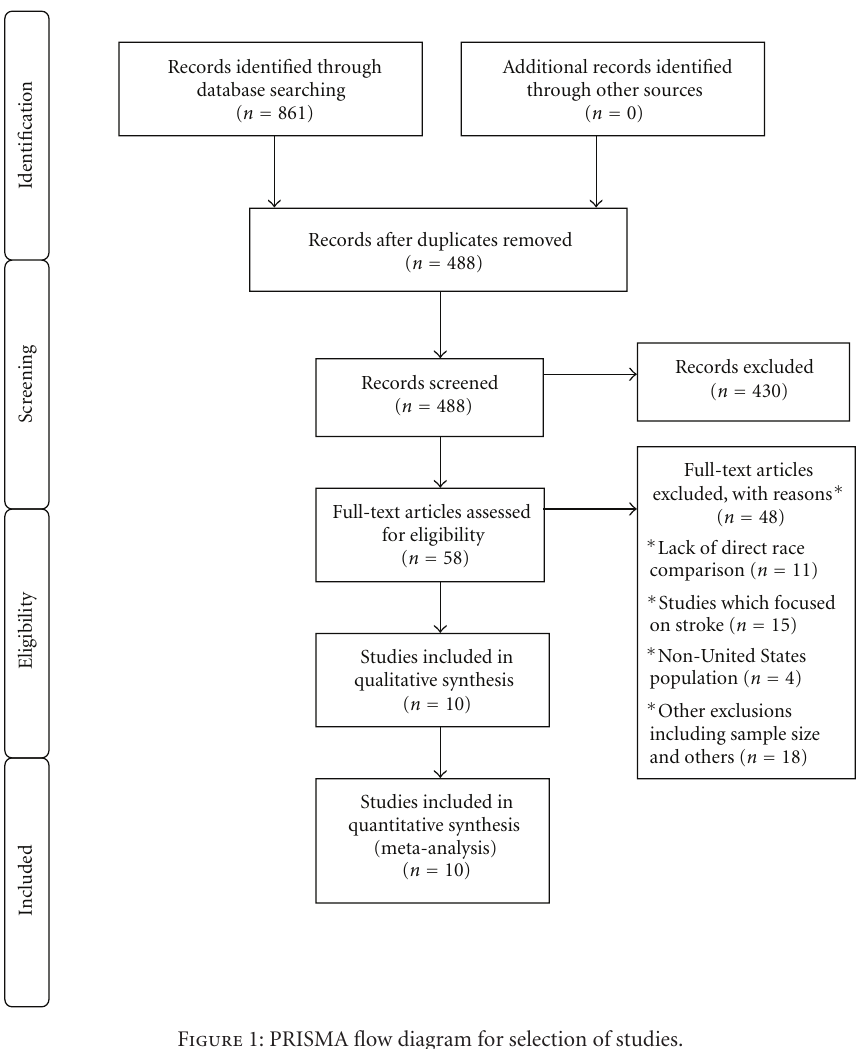
Figure 1: PRISMA flow diagram for selection of studies.